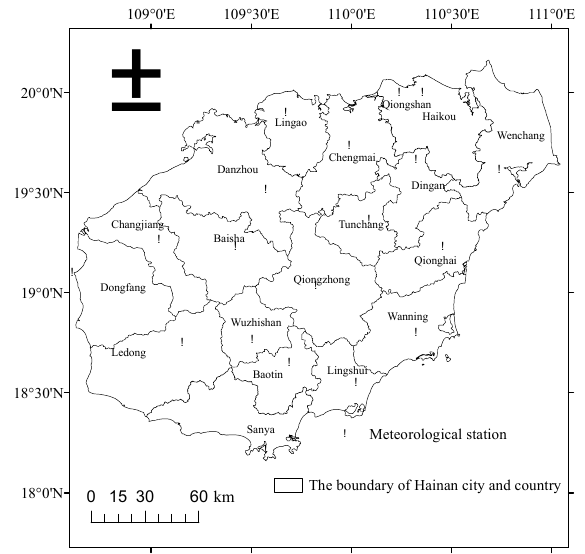
Figure 1. Meteorological stations spatial distribution map of Hainan Island.